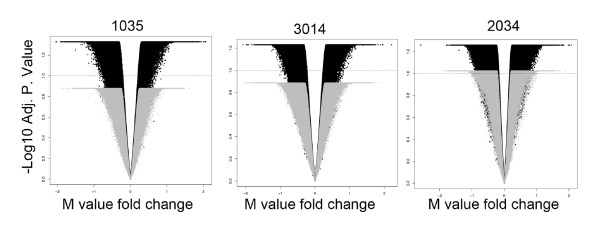
Comparison of biological versus technical variation for matched replicate samples. The data are represented as volcano plots of three MZ twin pairs (1035, 3014 and 2034; black) with an overlay of matched technical replicate DNA sample (gray). The x-axis represents the M-value fold change of variation across the four samples in each pair (replicate samples for each of twin 1 and 2 at birth and 18 months). The y-axis represents the -log10 FDR adjusted P-value for the moderated paired t-test. A genome-wide significance (FDR <0.1 for each individual pair) is denoted by the dotted horizontal line. In general, variation between biological replicates exceeds genome-wide significance and technical variation falls below genome-wide significance.